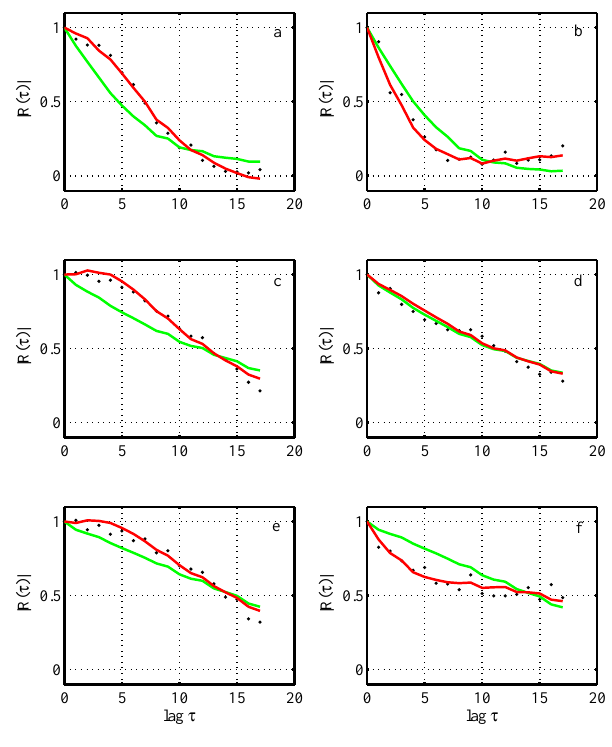
Fig. 4. Illustration of six typical ACFs reconstructed from SVD modes. Each ACF (black dots) has been reconstructed using either the first two modes (green curve) or the first three modes (red curve). Panels (a) to (f) refer to the location of these different ACFs in the parameter space displayed in Fig.